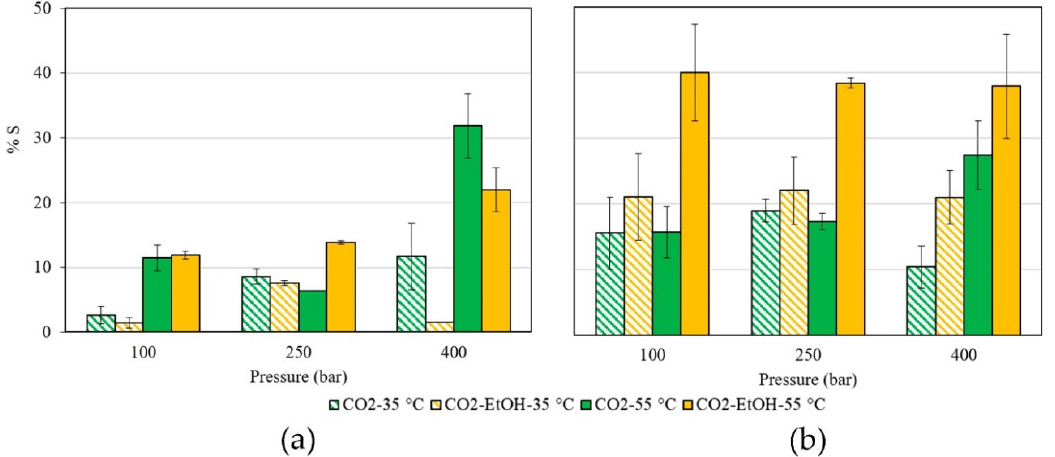
Figure 2. % Swelling of ( a ) PLA and ( b ) TPU filaments after supercritical treatment under 100, 250, and 400 bar using pure CO 2 and a CO 2 :EtOH 3% v / v mixture as solvents, at 35 °C and 55 °C. The experiments were carried out for 30 min, in duplicate.